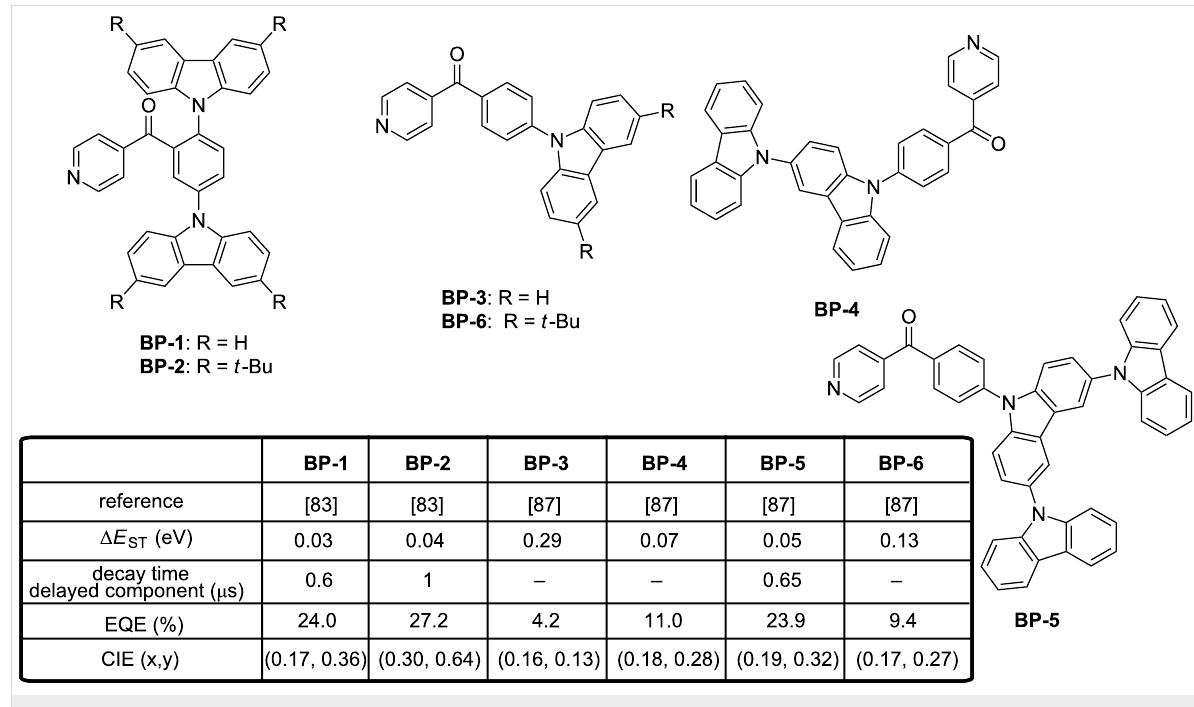
Figure 17: Benzoylpyridine-carbazole hybrid emitters BP-1 – BP-6